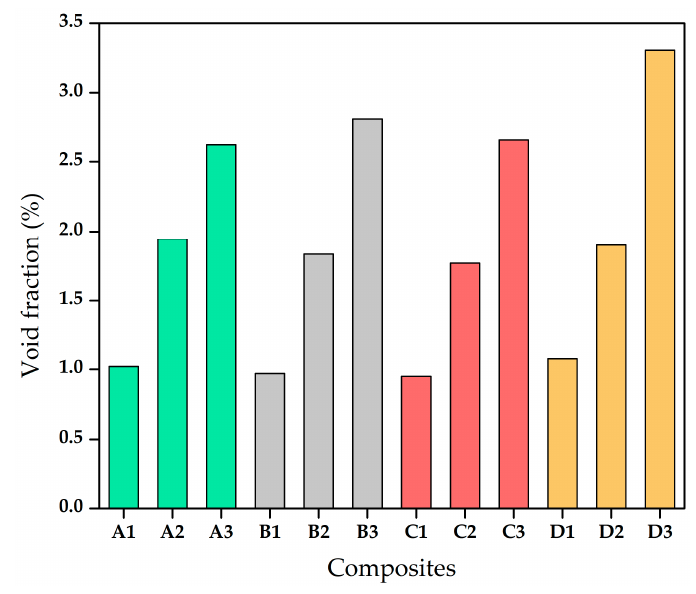
Figure 1. Void fraction (%) of composites. Table 3. Physical properties of the bagasse fibre composites.